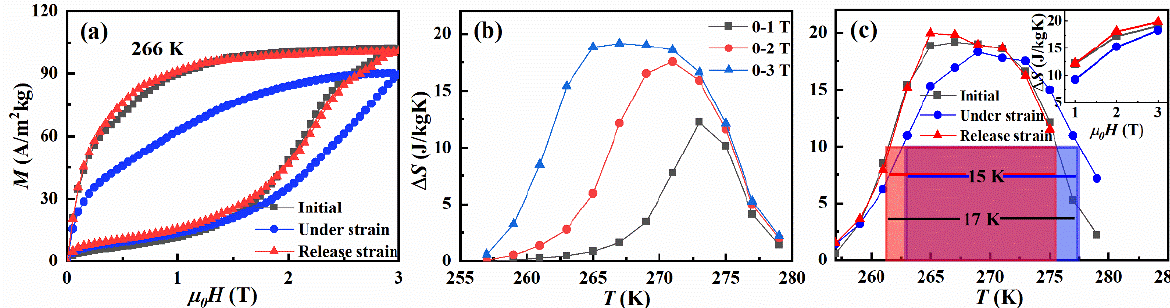
Figure 4. ( a ) Isothermal magnetization curves at 266 K. ( b ) Temperature-dependent entropy change under different magnetic fields for NCMS alloys in the initial state. ( c ) Comparison of the Δ S - T curves under a magnetic field change of 0 – 3 T for the cases in the initial state, compressive strain state, and releasing strain state, where the cooling temperature span is marked by the shadow area. The inset shows the comparison of the magnetic-field-dependent entropy change for the above three